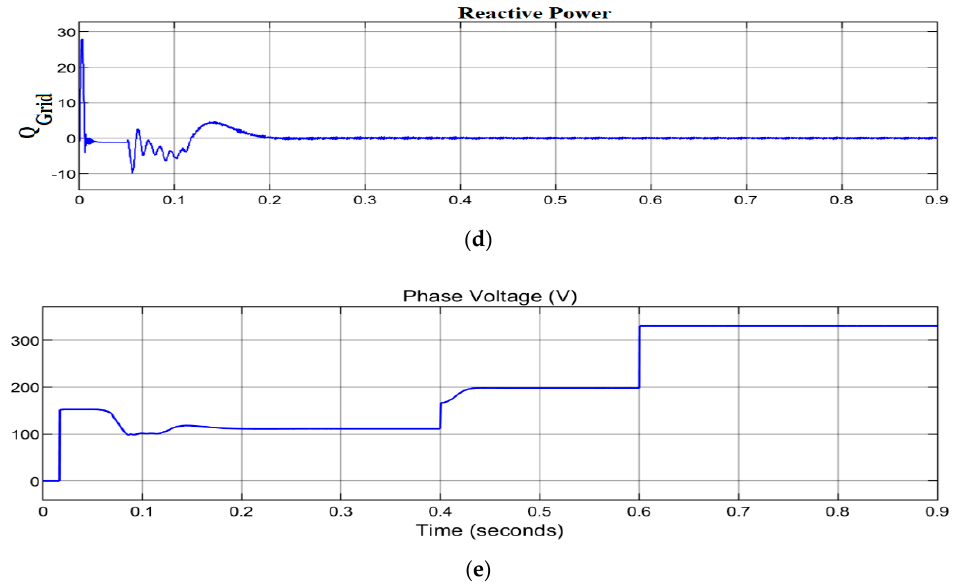
Figure 14. Voltage rise with Zero Grid Reactive Power ( a ) load varies at 0.4 s to 0.6 s, and switched off at 0.6 s to 0.9 s, grid current increases. ( b ) Reduction in the load power between 0.4 s to 0.9 s ( c ) Increase in power to the grid due to reduction in the load between 0.6 s to 0.9 s. ( d ) Reactive power during unity power factor mode of the STATCOM. ( e ) Increase in the phase voltage.